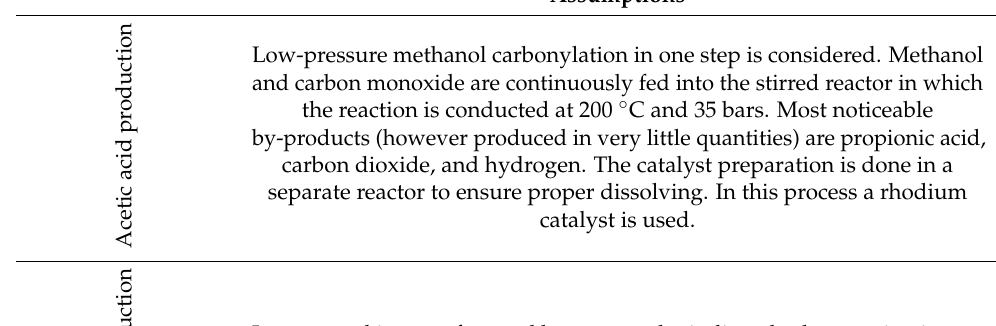
Table 7. LCA assumptions [38].